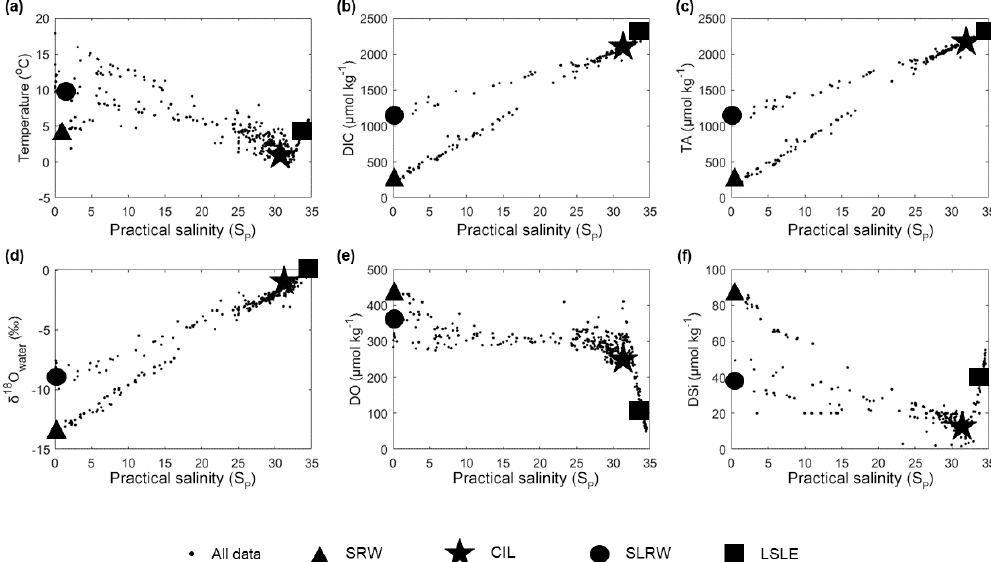
Figure A1. (a) Temperature, (b) dissolved inorganic carbon (DIC), (c) total alkalinity (TA), (d) δ 18 O water , (e) dissolved oxygen (DO) and (f) dissolved silicate (DSi) vs. practical salinity ( S P ) for samples collected in September 2014, May 2016, June 2017, November 2017 and May 2018. Each large symbol (square, circle, triangle and star) identifies distinct source water masses.